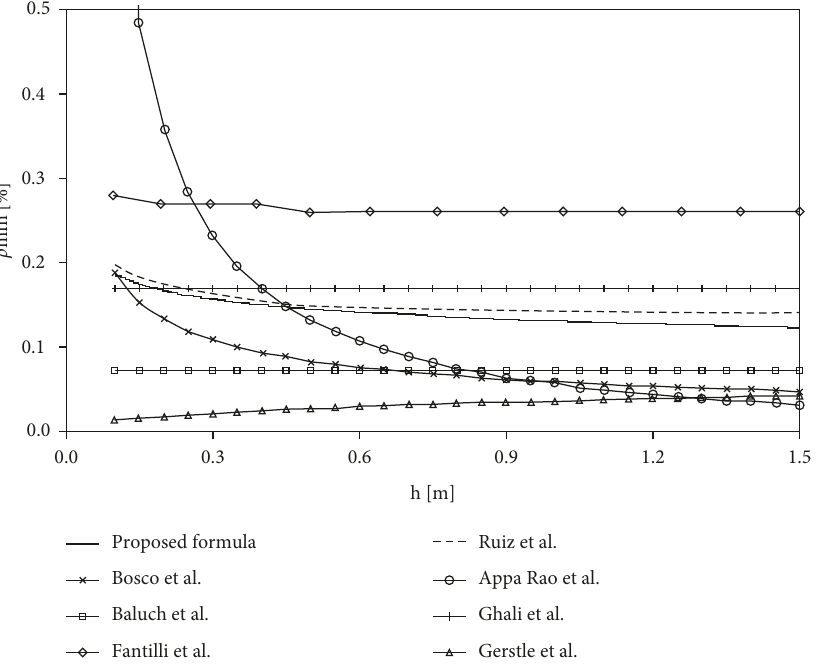
Figure 3: Proposed minimum reinforcement equation models verses beam depth, f